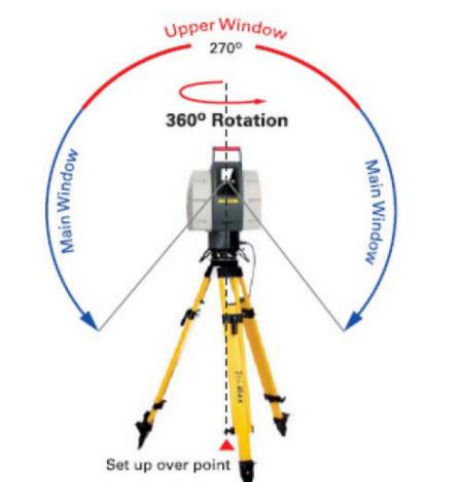
Figure 1. TLS Scanning direction (Cătălina & Andreea -